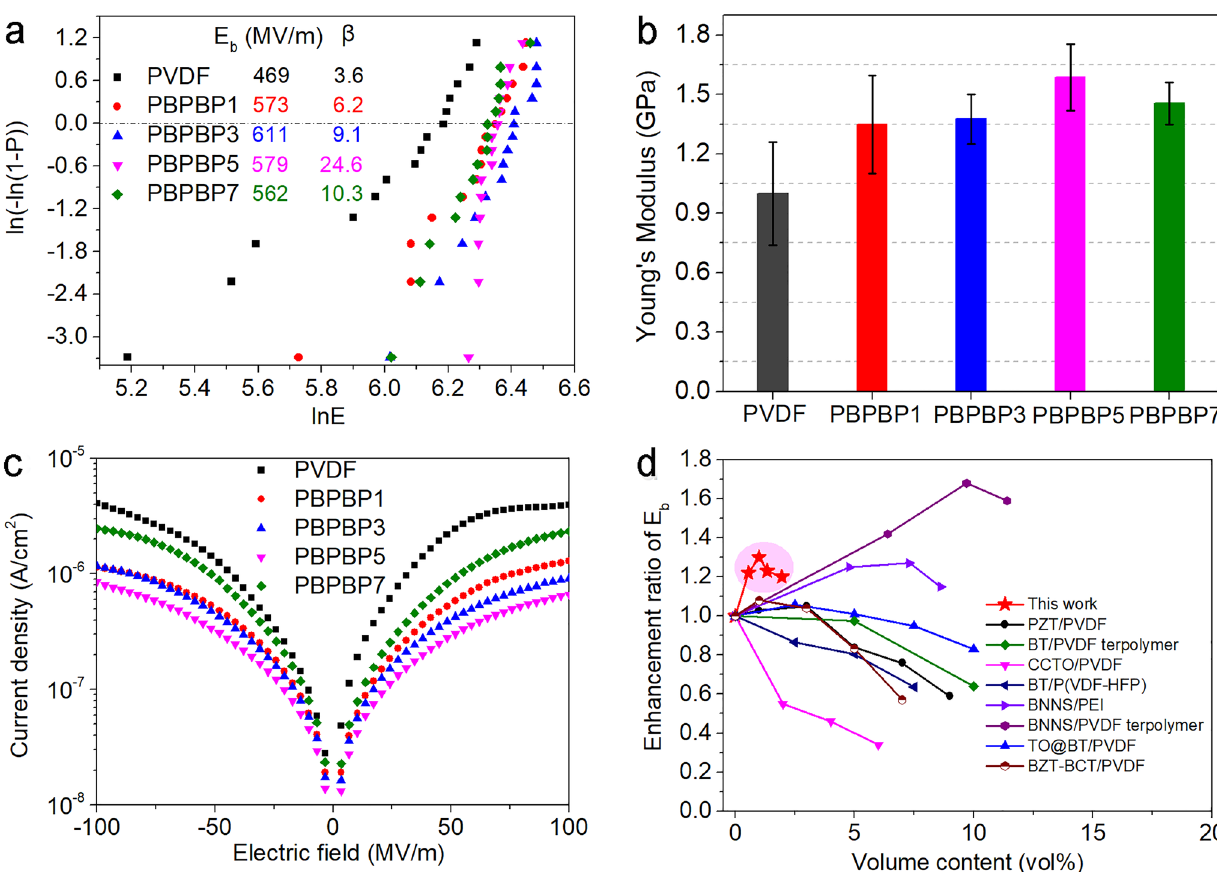
Fig. 4 a Weibull statistical distribution plots, b Young’s modulus, and c I-V curves of PVDF and PBPBP films. d Comparison of enhancement ratio of